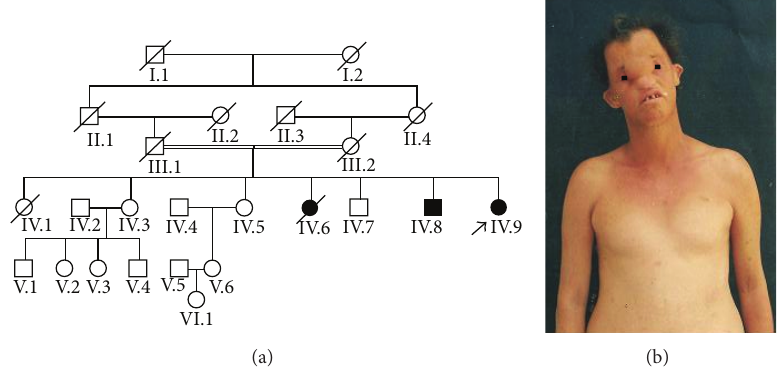
Figure 1: (a) Familiar tree. (b) The propositus: observe the following: excess of soft tissue on nasofrontal region, widely spaced teeth, cupped protruding ears, and absent